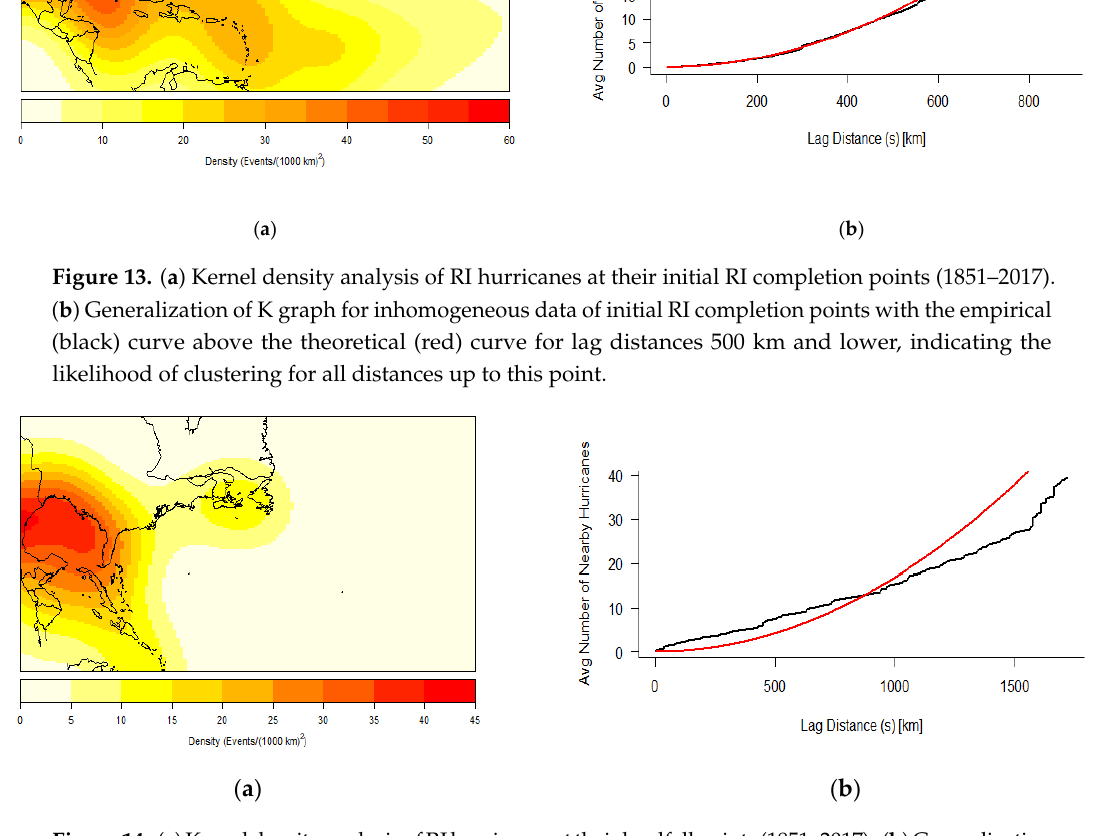
Figure 14. ( a ) Kernel density analysis of RI hurricanes at their landfall points (1851 – 2017). ( b ) Generalization of K graph for inhomogeneous data of RI landfall points with the empirical (black) curve above the theoretical (red) curve until a 750-km lag distance and the theoretical curve over the empirical curve for all of the following lag distances.